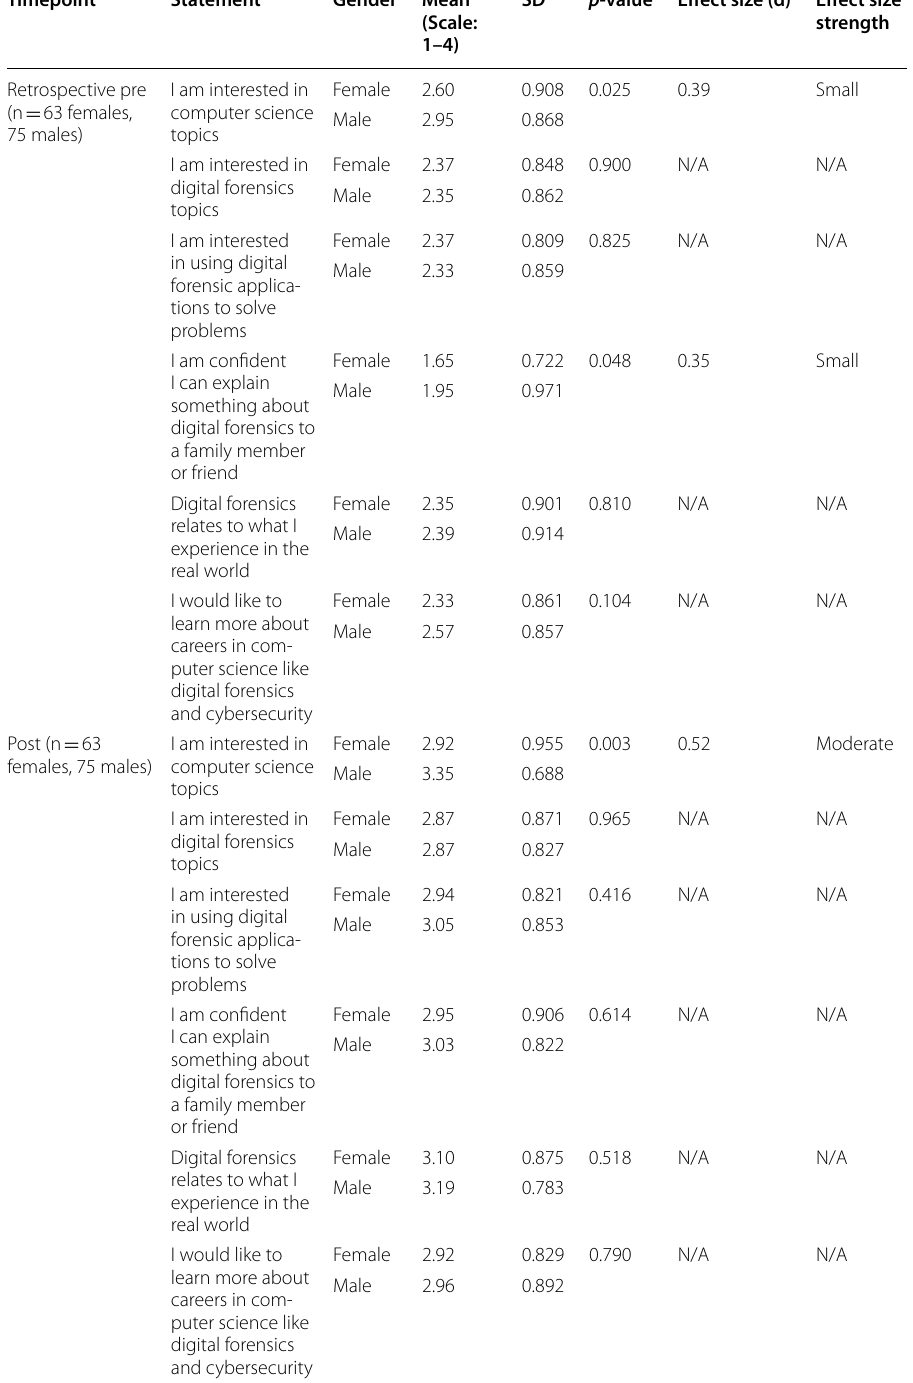
Table 4 Independent samples t-test comparison by gender of students’ understanding of and interest in digital forensic science and related careers based on retrospective pre-post survey questions Timepoint Statement Gender Mean (Scale: 1–4)